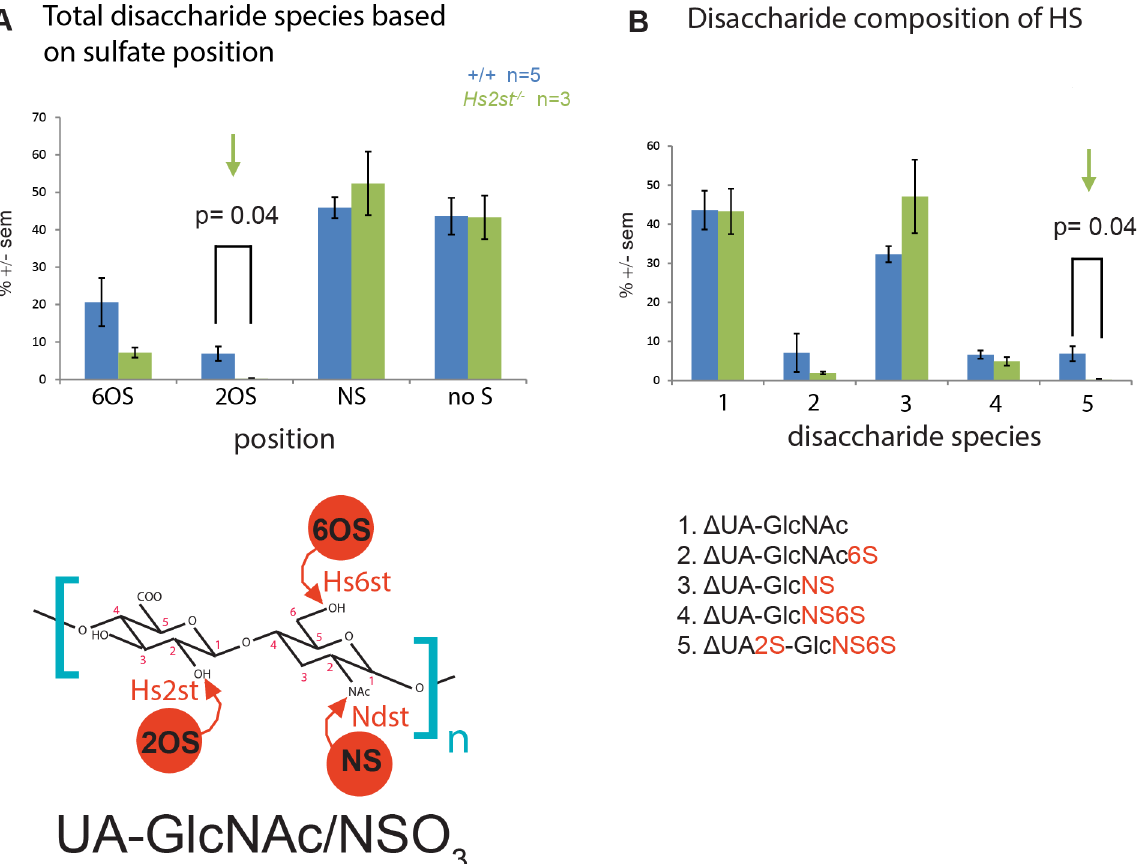
Fig 1. Disaccharide analysis of HS from E16.5 wild-type and Hs2st -/- telencephalon. ( A ) Proportion of sulfate occupancy in specific positions. The highest proportion of sulfate occupancy found in wild-type HS was in the N- position, followed by non-sulfated, 6-O, and 2-O positions which were 48%, 45%, 20%, and 7% respectively. HS from Hs2st -/- mutant telencephali had no significant change in the proportions of sulfate occupancy except for a significant reduction (p = 0.04) in 2-O HS sulfation in the Hs2st -/- mutant (green arrow). Diagram below graph shows position of 2-O, 6-O, or N- sulfation of the UA-GlcNAc/NSO 3 disaccharide and corresponding HST enzyme activity. ( B ) Analysis of disaccharide composition of HS between wild-type and Hs2st -/- whole telencephalon. The only significant difference (green arrow) was the reduced trisulphated Δ UA2S-GlcNS6S disaccharide in Hs2st -/- HS (p = 0.04). There was no significant difference between wild-type and Hs2st -/- HS for other disaccharide species ( Δ UA-GlcNAc, Δ UA-GlcNAc6S, Δ UA-GlcNS, Δ UA-GlcNS6S). Statistical analysis was done using ANOVA with Tukey posthoc test (wild-type, n = 5; Hs2st -/- , n = 3).